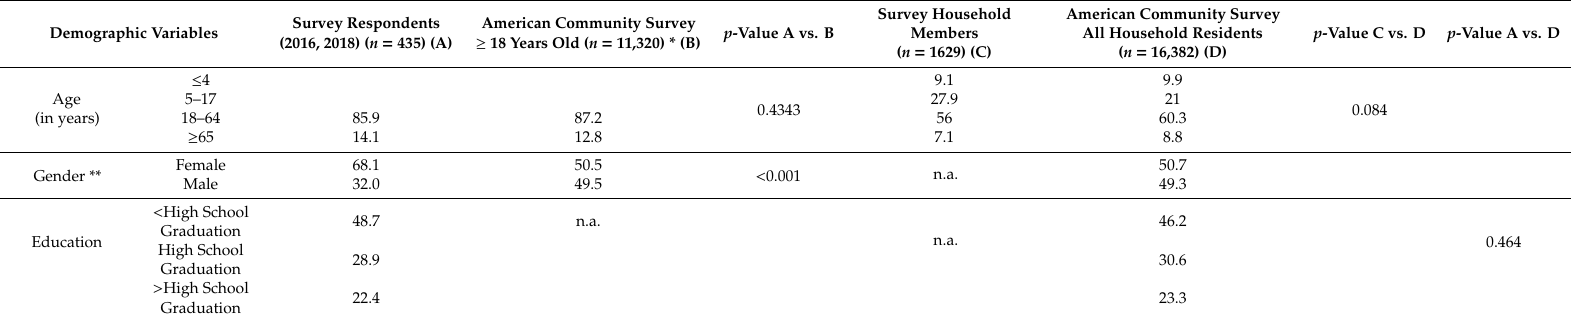
Table 1. Demographic characteristics of survey respondents, household members, and GHIB census block group